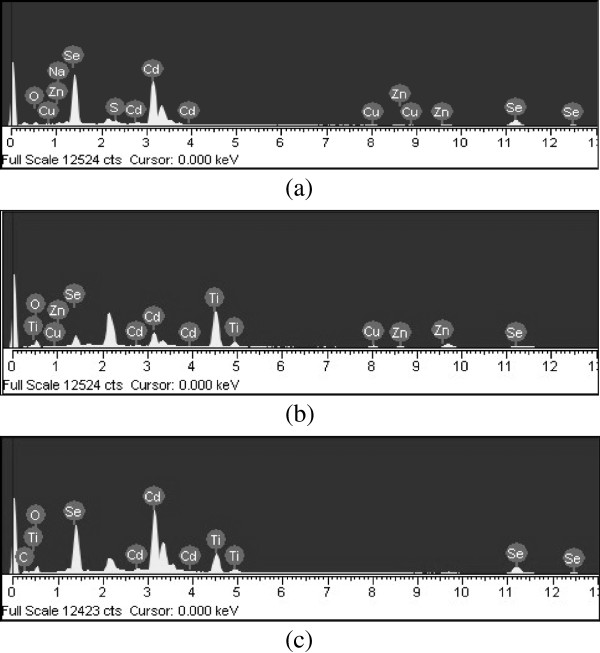
EDX elemental microanalysis of CdSe (a), CdSe-TiO2 (b), and CdSe-C60/TiO2 (c), they are kinds of elements such as Cd, Se, Ti, O and C.